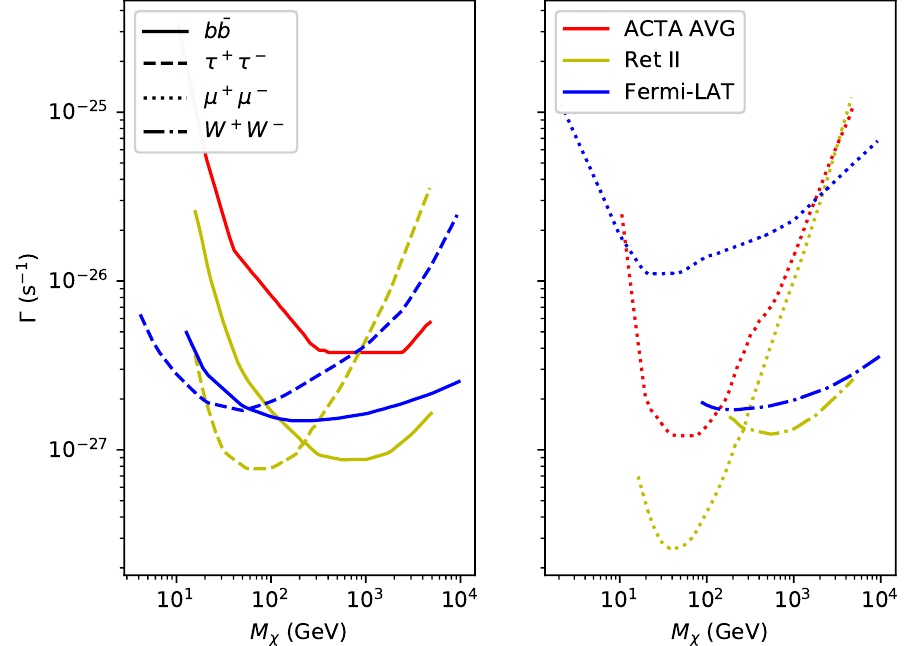
Figure 2. Decay rate limits from existing searches, presented at a confidence level of 95%. Four annihilation channels are covered and we display results from Fermi-LAT [49], the AVG diffusion scenario from [29] (limited to channels quoted in the reference), and Reticulum II results from [30]. The left panel shows the b -quark ( bb ) and τ -lepton channels. The right panel shows W -boson and muon